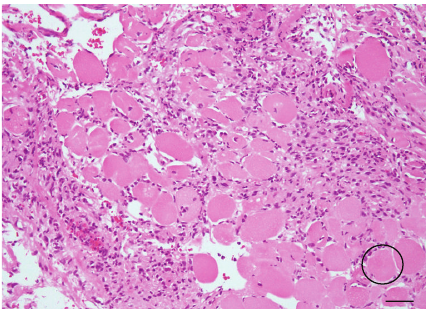
Figure 4: Histopathological findings of the pharyngeal constrictor muscle obtained during surgery. Bar: 50 𝜇 m. Inflammatory cell infiltration is observed among the striated muscle fibers